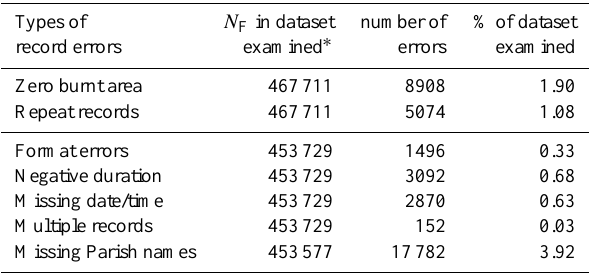
Table 3. Types and numbers of record errors we identified in the 1980–2005 Portuguese Rural Fire Database (PRFD). Total number of values in the original “raw” PRFD is 467711